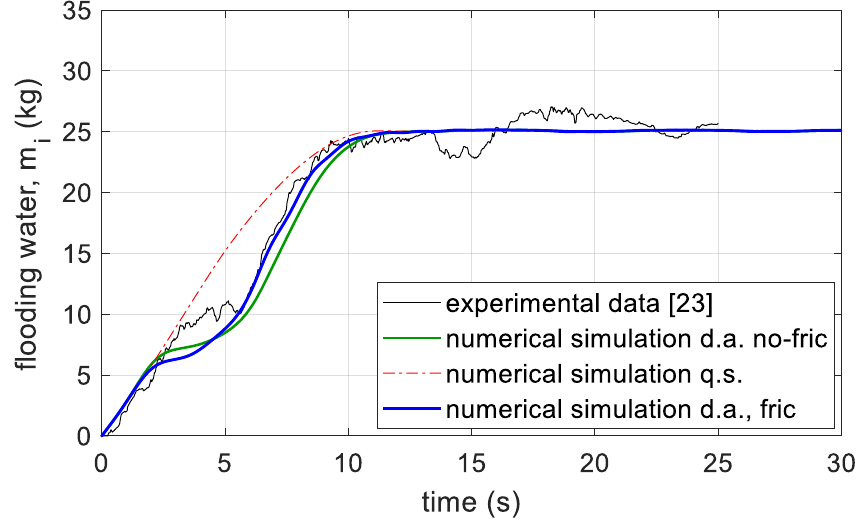
Figure 5. Transient flooding water in the damaged compartment: experimental vs. numerical results.